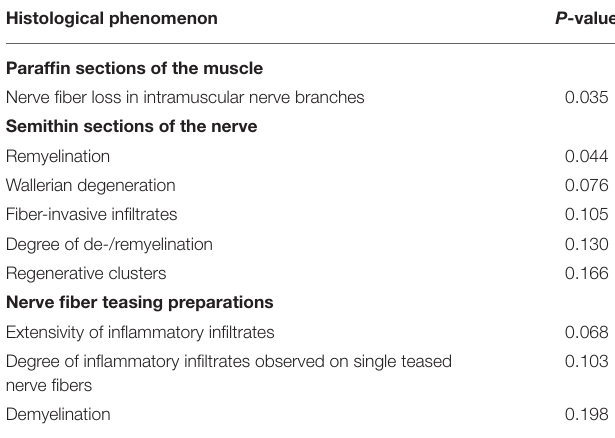
TABLE 3 | Significance of histological parameters in the univariate